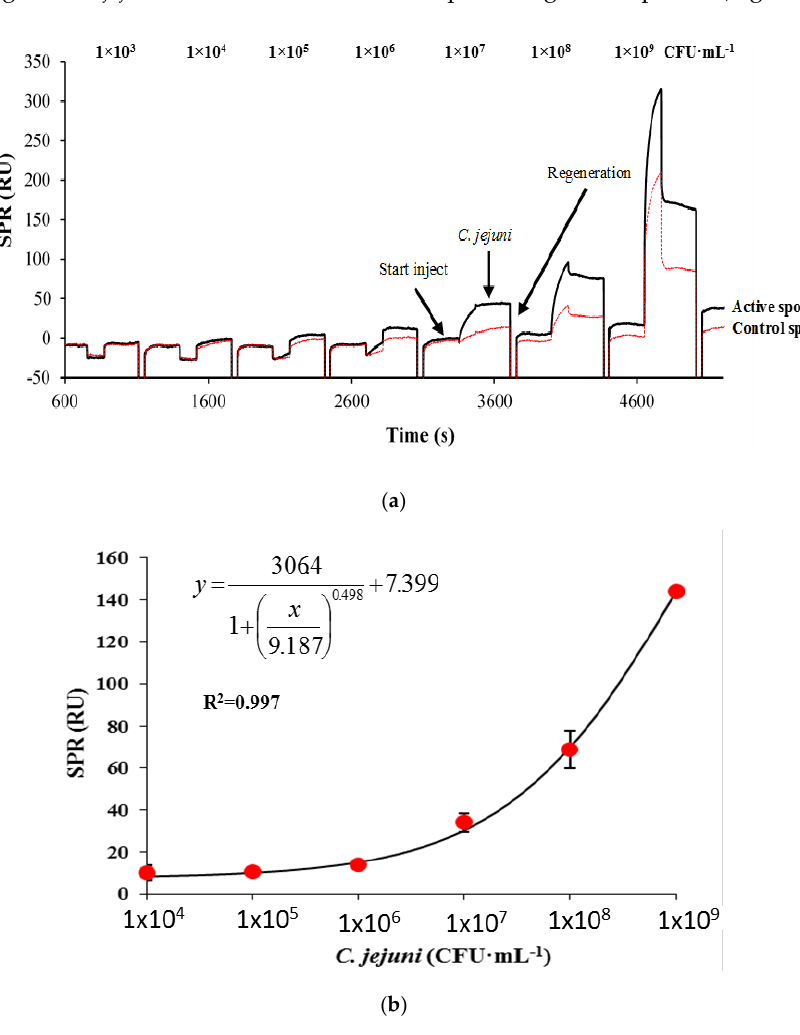
Figure 2. The SPR sensorgram showing the binding response of C. jejuni in a direct assay format ranging from 1 × 10 3 to 1 × 10 9 CFU·mL −1 prepared in PBS buffer injected (3 min) onto 70 µg·mL −1 of capture antibody ( a ), and the corresponding standard curve for the direct assay ( b ). The surface was regenerated by 100 mM HCl after every injection of C. jejuni . Bars represent mean ± standard deviation of triplicates.